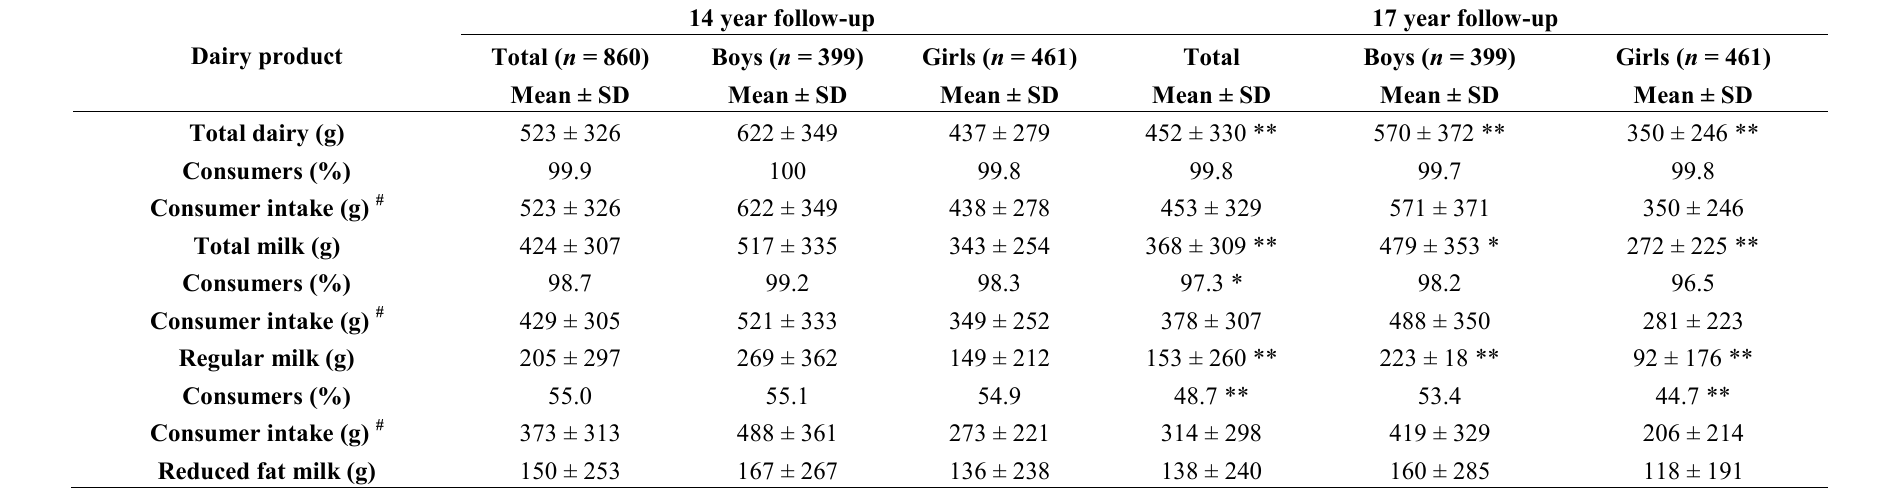
Table 2. Daily intake of dairy products for 14 and 17 year Raine study follow-up participants for the total group and those who are consumers (>1